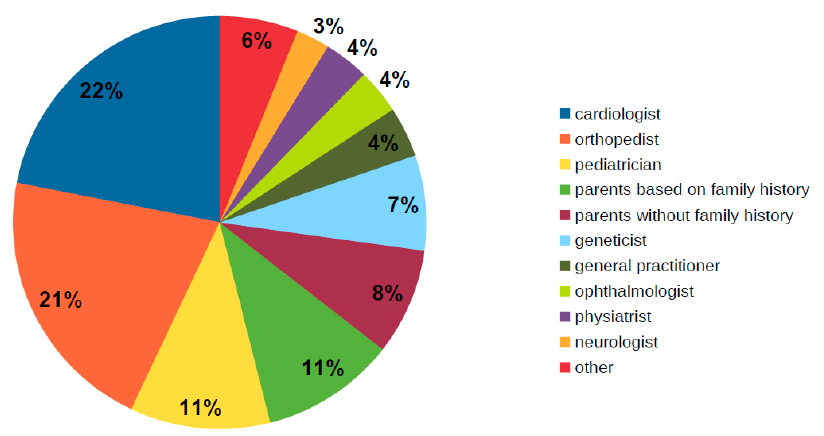
Figure 2. Diagram presenting specialists who were first to suspect Marfan syndrome (including